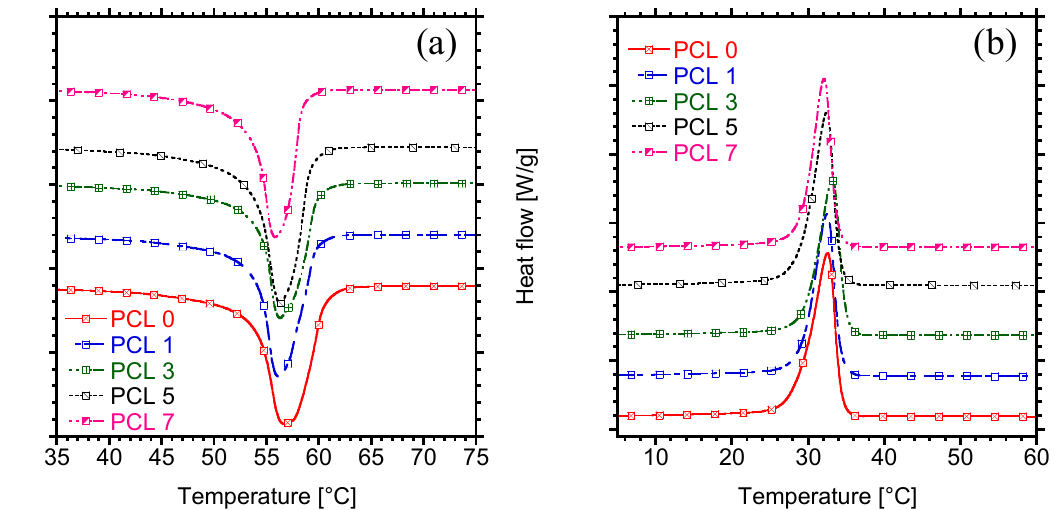
Figure 6. ( a ) DSC melting curves and ( b ) Melt crystallization curves of PCL and PCL/HAP composites.